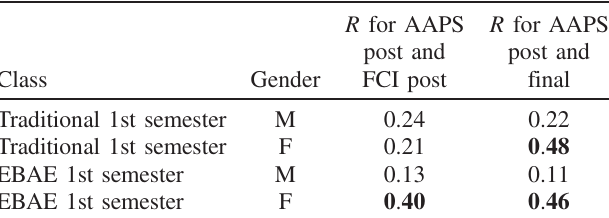
TABLE IV. Correlation coefficients ( R ) for the AAPS survey scores and final exam or FCI scores for different types of courses in first semester classes, broken down by gender. R > 0 . 3 appears in